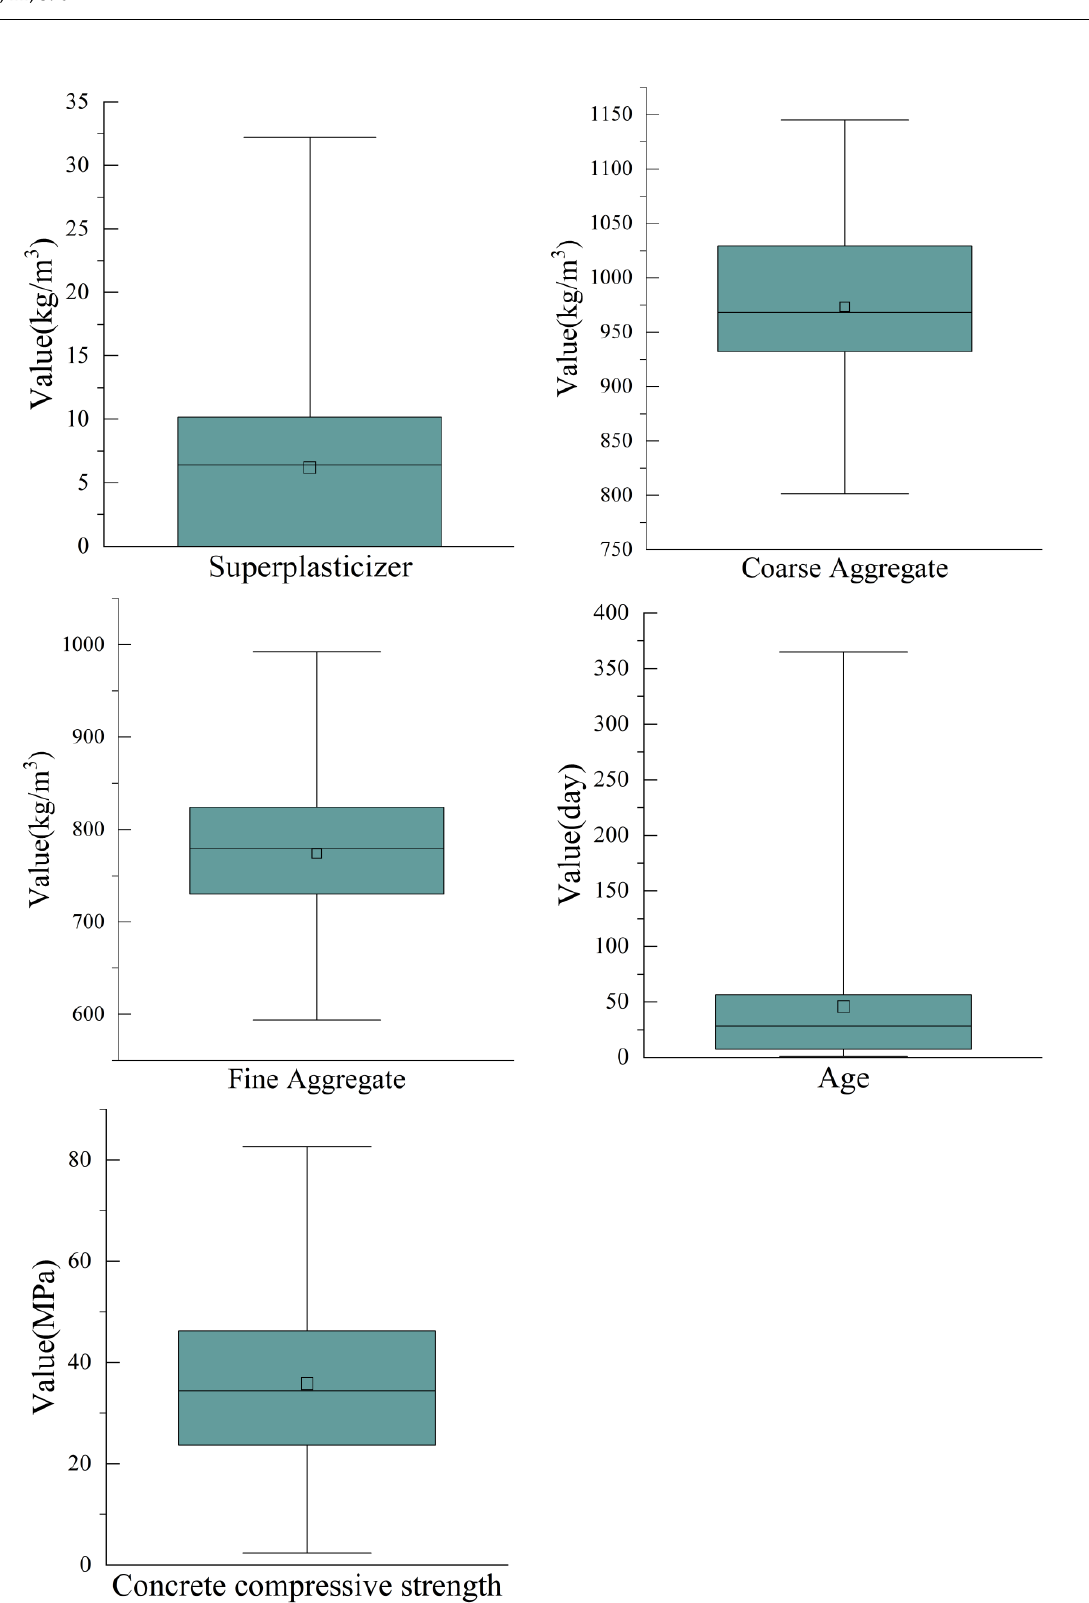
Figure 10. Range of values for nine parameters.